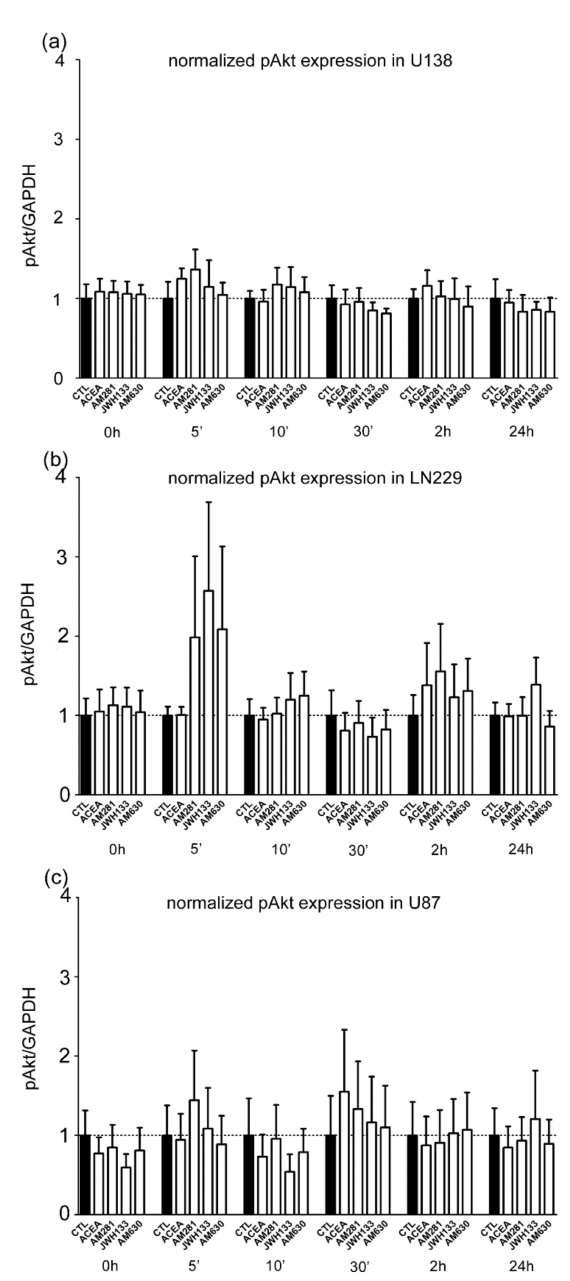
Figure 4. Activation of PI3K-Akt pathway in glioblastoma cell lines ( a ) U-138 MG, ( b ) LN229, and ( c ) U-87 MG. After 0 min, 5 min, 10 min, 30 min, 2 h, and 24 h no significant changes were observed in all examined cell lines (U-138 MG: n = 5–7, LN229: n = 5–9, U-87 MG: n = 4–7) in groups treated with agonists (ACEA, 10 µ M; JWH133, 10 µ M) and antagonists (AM281, 1 µ M; AM630, 1 µ M) for CB 1 and CB 2